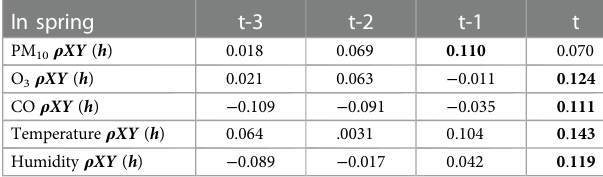
TABLE 1 Cross-correlation coef fi cients between the number of asthma exacerbations (t) and atmospheric substance (t-n) in spring. In spring